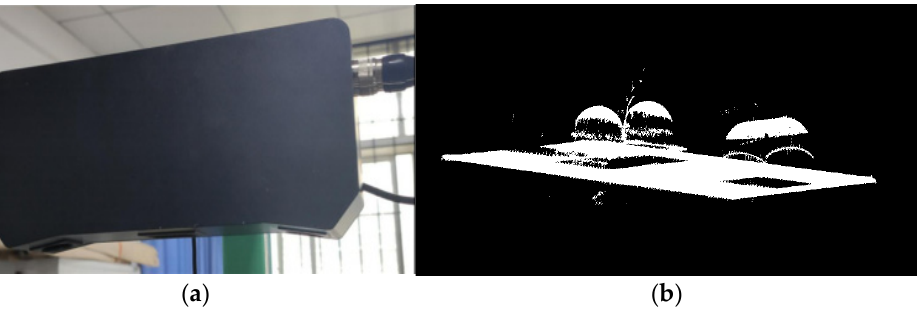
Figure 6. Experimental apparatus and scanning results. ( a ) Three-dimensional scanner; ( b ) actual scanned point cloud.